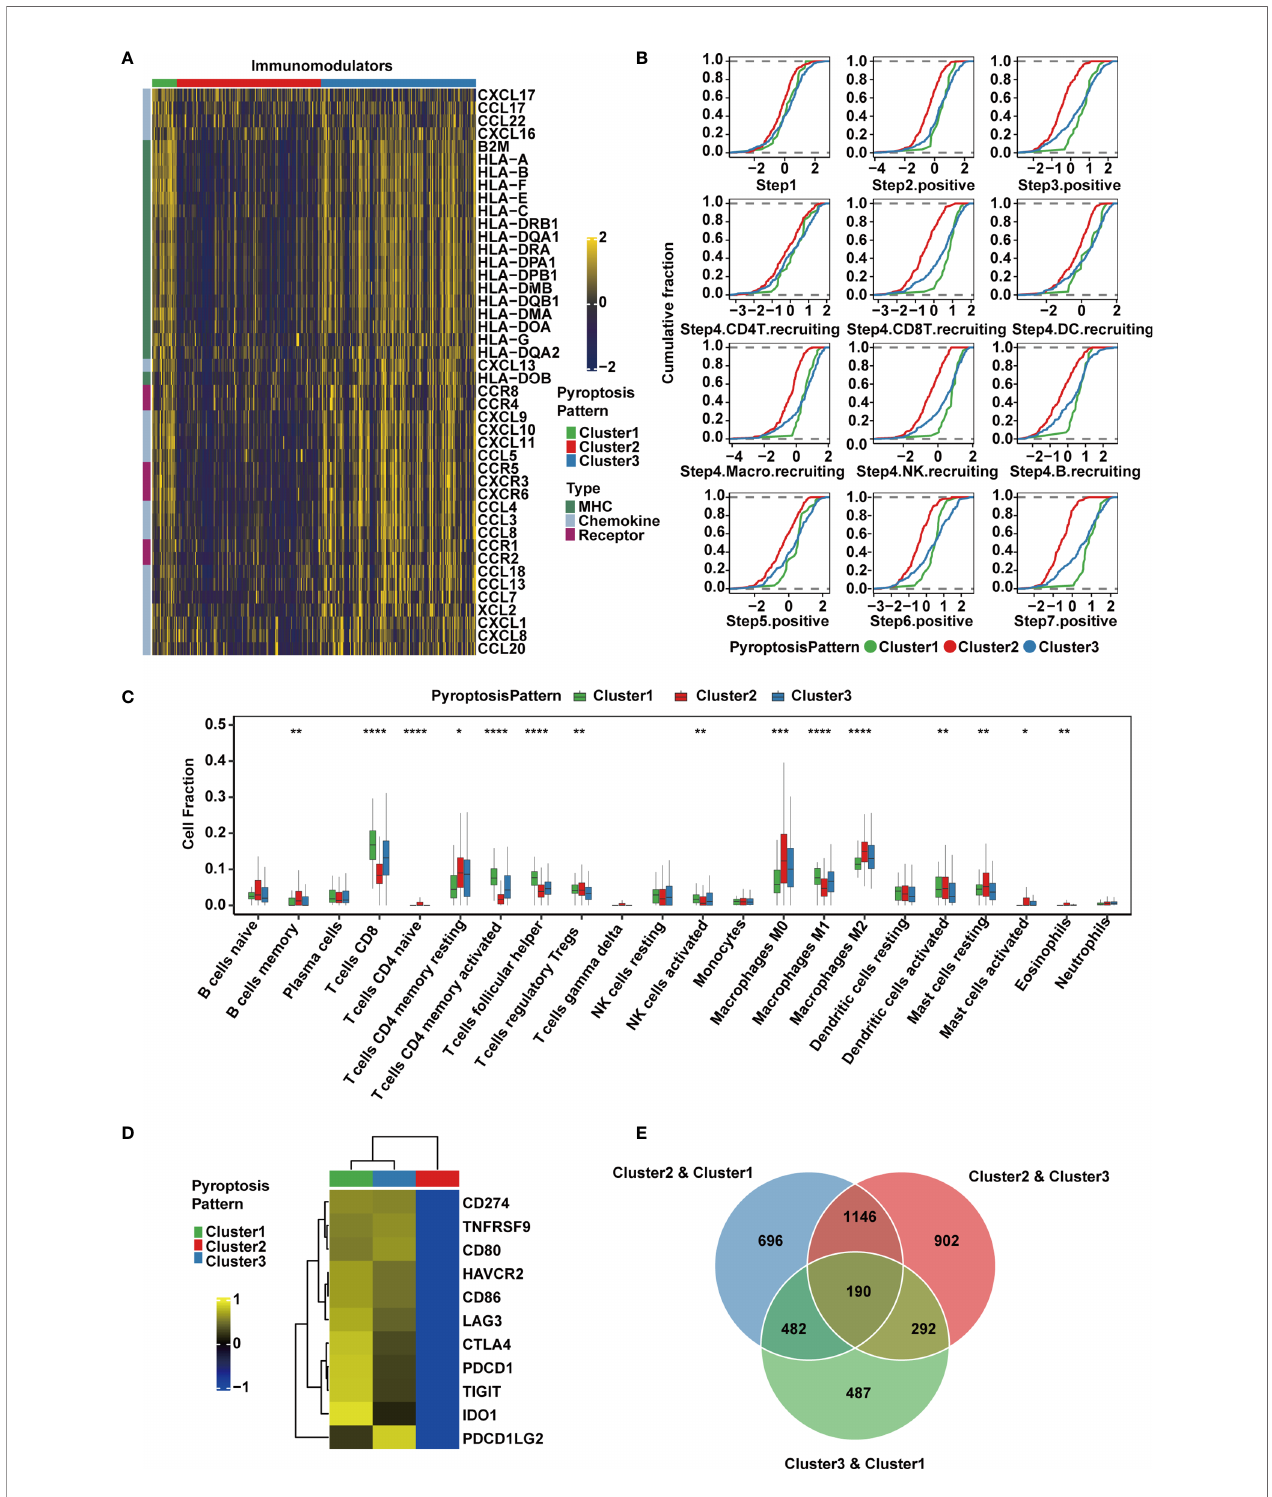
FIGURE 3 | TME and transcriptomic characteristics of the three distinct pyroptosis patterns in the TCGA-MIBC cohort. (A) Differences in the expression of chemokines, receptors and MHC molecules between the three pyroptosis patterns in TCGA-MIBC. (B) Differences in various steps of the cancer immunity cycle between three pyroptosis patterns in TCGA-MIBC. (C) The abundance of each TME-in fi ltrating cell type in three pyroptosis patterns. The asterisks represent the statistical P value (*p < 0.05; **p < 0.01; ***p < 0.001; ****p < 0.0001). (D) Heatmap representing the expression level of immune checkpoint genes in the three clusters. (E) Venn diagram showing pairwise DEGs for the three pyroptosis